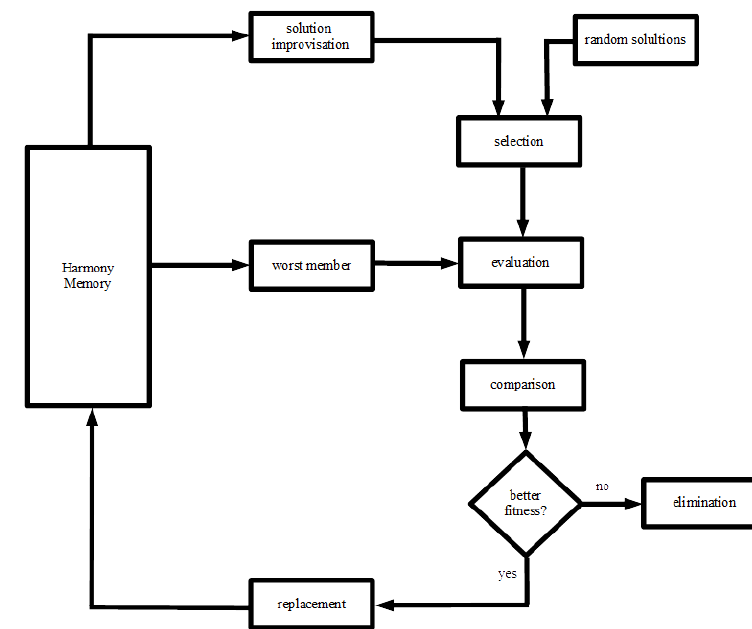
Figure 2. Flowchart of the HS method [14].